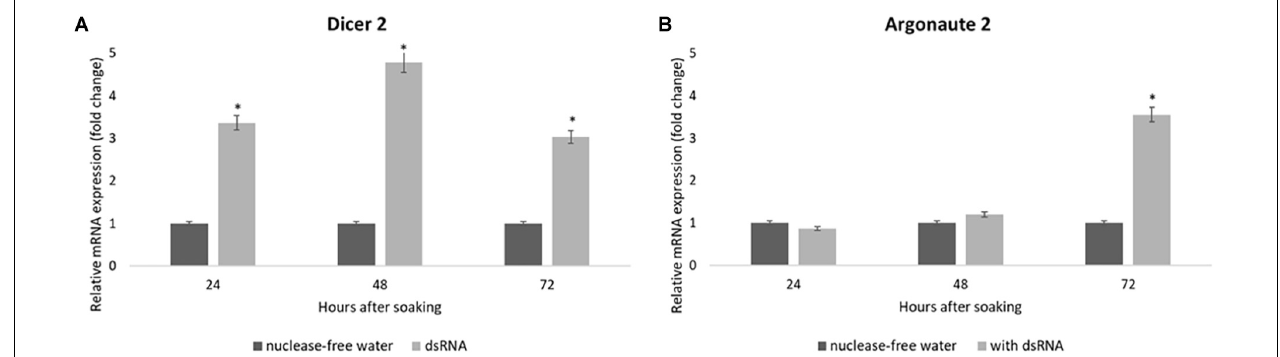
FIGURE 7 | Relative mRNA expression of Dicer-2 (A) and Argonaute-2 (B) in Anastrepha fraterculus larvae in response to dsGFP soaking after 24, 48, and 72 h (500 ng/ µ l). Nuclease-free water was used as control. The mRNA levels were normalized using α -tubulin and actin as reference genes. The columns represent the mean ± SE ( n = 3). ∗ p ≤ 0.05 ( t